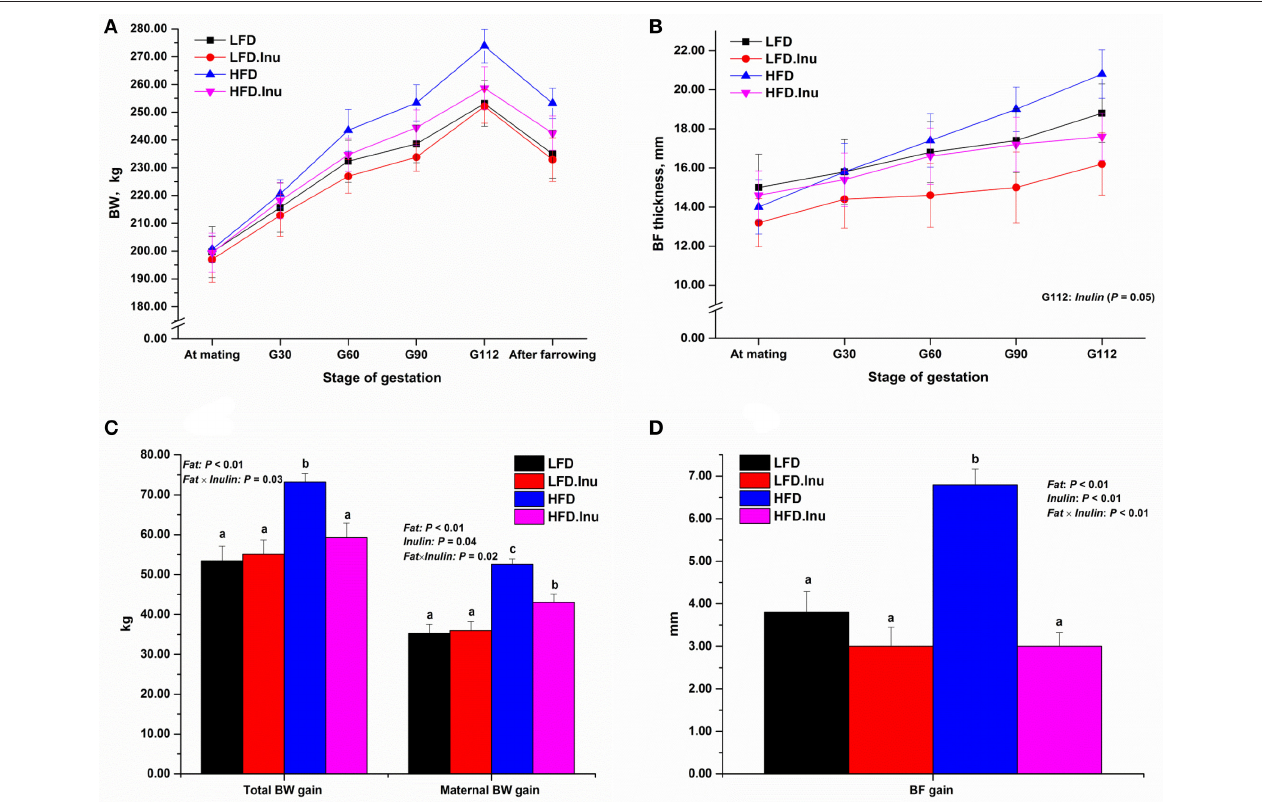
FIGURE 1 | (A,C) Body weight (BW) and (B,D) Backfat (BF) changes during gestation. Data were expressed as means ± SEM. Sows were regarded as the experimental units, n = 5 for each treatment. (B) BF thickness on G112: P = 0.05 for inulin effect. (C) Total BW gain: P < 0.01, = 0.08, and = 0.03 for fat, inulin and fat × inulin interaction effect, respectively; Maternal BW gain: P < 0.01, = 0.04, and = 0.02 for fat, inulin and fat × inulin interaction effect, respectively. (D) BF gain: P < 0.01 for fat, inulin, and fat × inulin interaction effect, respectively. When significant main effects or interative effects were observed, the means were compared using the least significant difference method with a P < 0.05 indicating significance. Therefore, mean values without a common letter are significantly different for each parameter in the figure ( P < 0.05). LFD, low fat diet; LFD.Inu, low fat diet with inulin addition; HFD, high fat diet; HFD.Inu, high fat diet with inulin addition; maternal BW gain, net weight gain of sow itself. Only significant p -values were presented in the